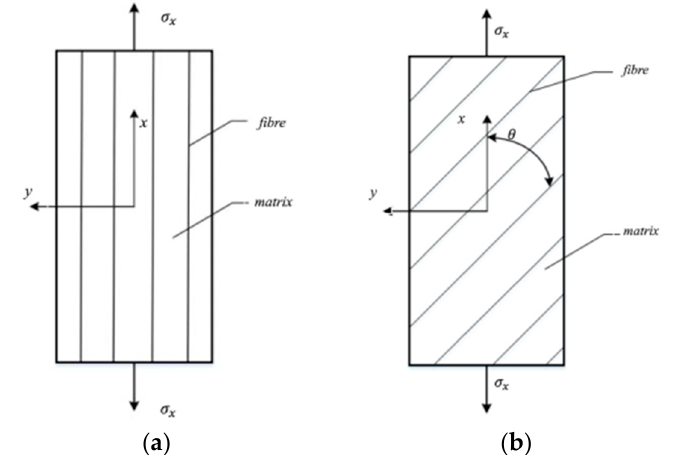
Figure 1. Illustration of on-axis tension and off-axis tension tests: ( a ) On-axis tension test; ( b ) off-axis tension test.